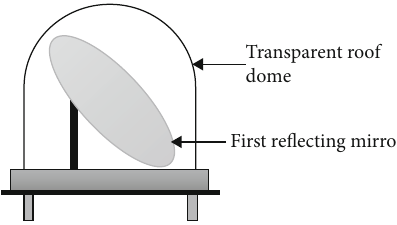
Figure 10: Mirror sunlighting system showing the fi rst re fl ecting mirror (source: adapted from